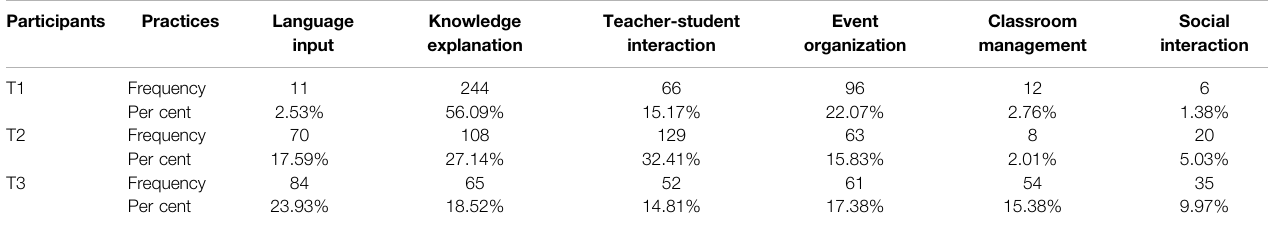
TABLE 3 | Teachers practices about the functions of